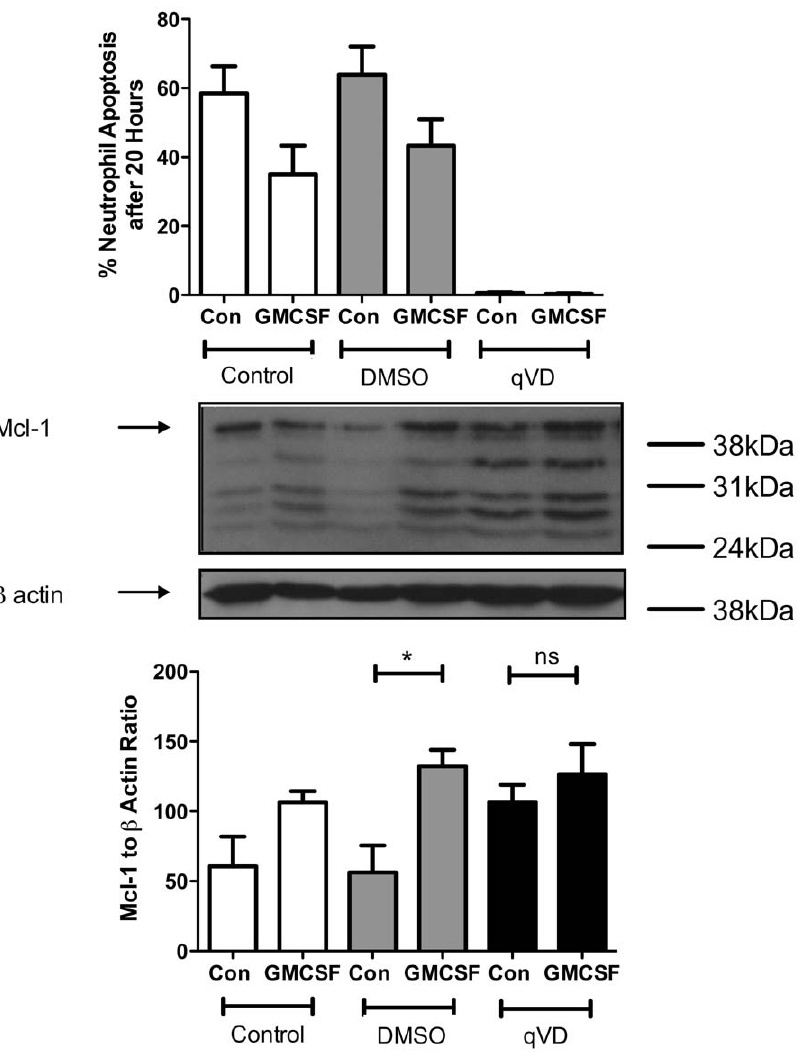
Figure 3. At late timepoints, Mcl-1 levels are maintained by highly effective caspase inhibition. Neutrophils were cultured 6 caspase inhibitor, Q-VD.OPh (QVD), 6 DMSO (vehicle control) for 20 hours. Neutrophil apoptosis rates were determined by cytospin analysis (upper panel), and relative Mcl-1 levels determined using western blotting for 3 independent experiments (middle panel) as previously shown. In the presence of Q- VD.OPh, there was no significant difference in levels of Mcl-1 in control neutrophil lysates compared to lysates from GMCSF treated cells (*p , 0.001 for control vs GMCSF, one way ANOVA with Bonferroni’s post-test correction, n=3.)